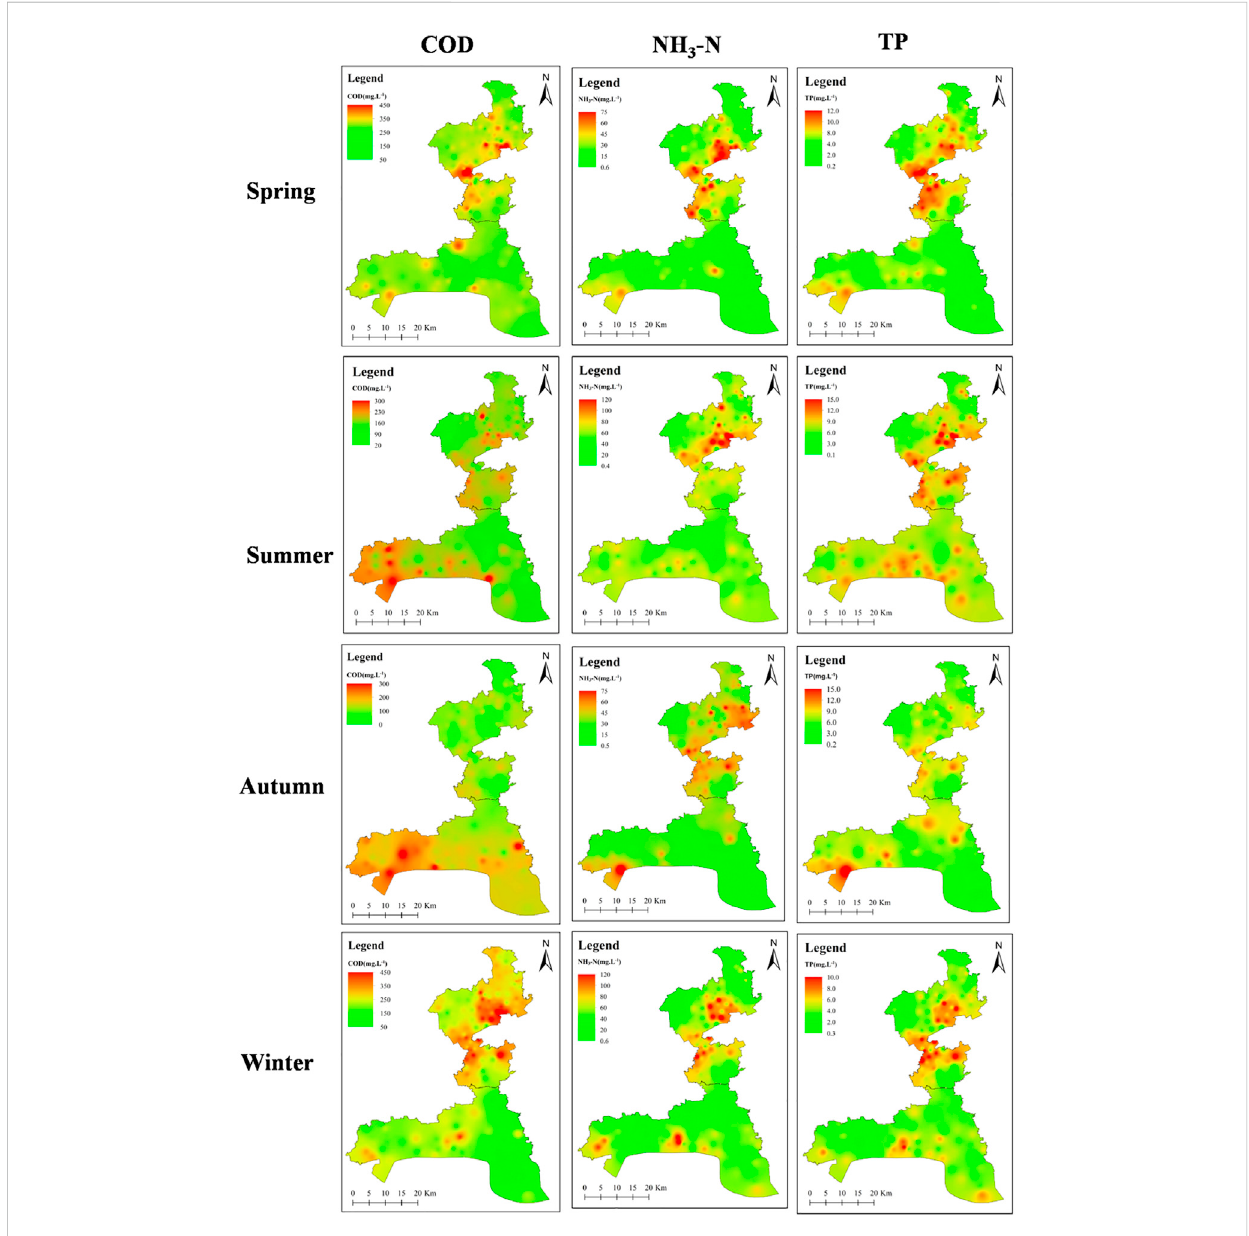
FIGURE 3 Main pollutants of in fl uent from 160 DSTFs across four